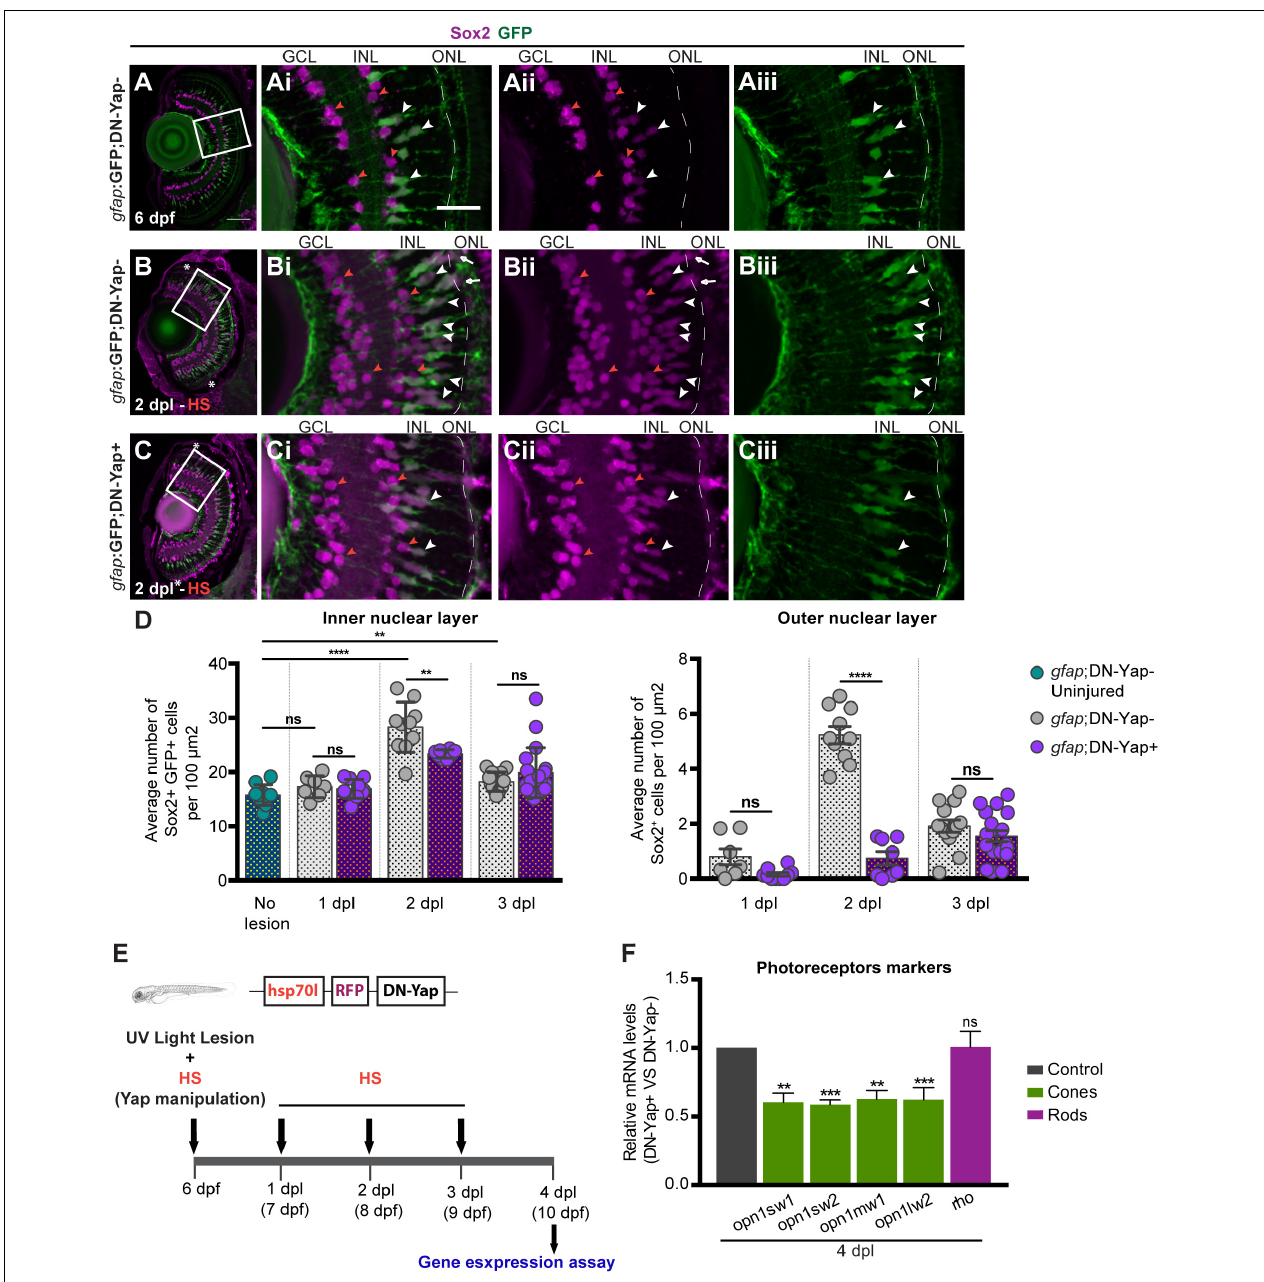
FIGURE 3 | Yap is required to regulate the number of Sox2-positive Müller glia cell (MG) progenitor cells and expression of photoreceptor markers after photoreceptor-induced light lesion. (A–C) Transverse cryosections of uninjured 6-dpf gfap :GFP;DN-Yap − control retina (A) , 2-dpl gfap :GFP;DN-Yap − (B) and gfap :GFP;DN-Yap+ (C) retinas subjected to UV light lesion and heat shock (HS) at 6 dpf, immunostained for Sox2 (magenta) and green fluorescent protein (GFP) (green). Sox2 is localized in amacrine cells (ACs) (orange arrowheads) (magnified, Ai,Aii,Bi,Bii,Ci,Cii ), MGs (white arrowheads), and progenitors in the outer nuclear layer (ONL) (white arrows) (magnified, Ai–Aiii,Bi–Biii,Ci–Ciii ). (D) Quantification of Sox2 + GFP + cells in gfap :GFP;DN-Yap − uninjured controls at 6 dpf, and lesioned gfap :GFP;DN-Yap − and gfap :GFP;DN-Yap + larva retinas from 1 to 3 dpl, in inner nuclear layer (INL) and ONL. (E) Schematic representation of the UV light lesion and HS assay. (F) Relative gene expression of photoreceptor markers at 4 dpl ( n = 7 biological replicates) in DN-Yap + versus DN-Yap − controls. ns, non-significant; ** p < 0.01, *** p < 0.001, **** p < 0.0001. Unpaired t -test with Welch’s correction for Sox2+ cell quantification. Paired t -test for the relative gene expression of photoreceptor markers. Asterisks delimitate the lesioned region. Dashed lines delimitate INL from ONL. White boxes delimitate magnified (Ai–Aiii,Bi–Biii,Ci–Ciii) . Scale bars correspond to 50 µ m in (A) and 20 µ m in magnified (Ai) .